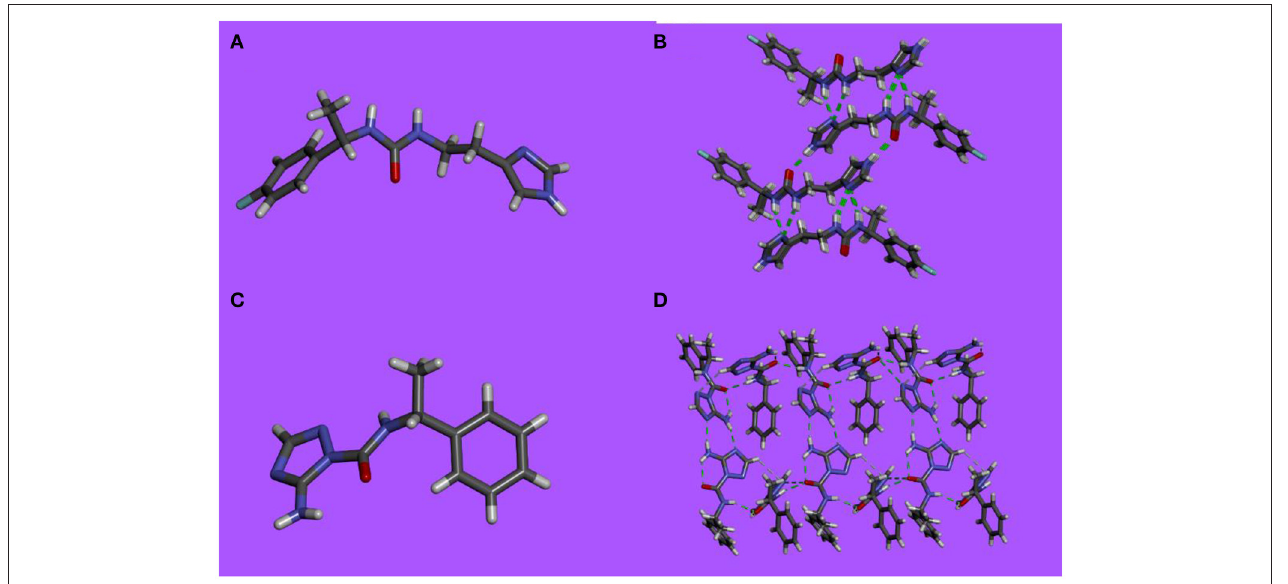
FIGURE 1 | X-ray single-crystal structure and packing in stick representation of (A,B) 3 and (C,D) 5 .